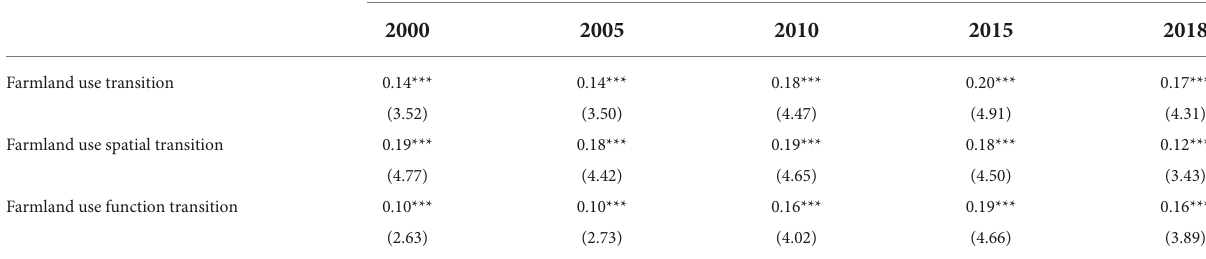
TABLE 4 The results of Global